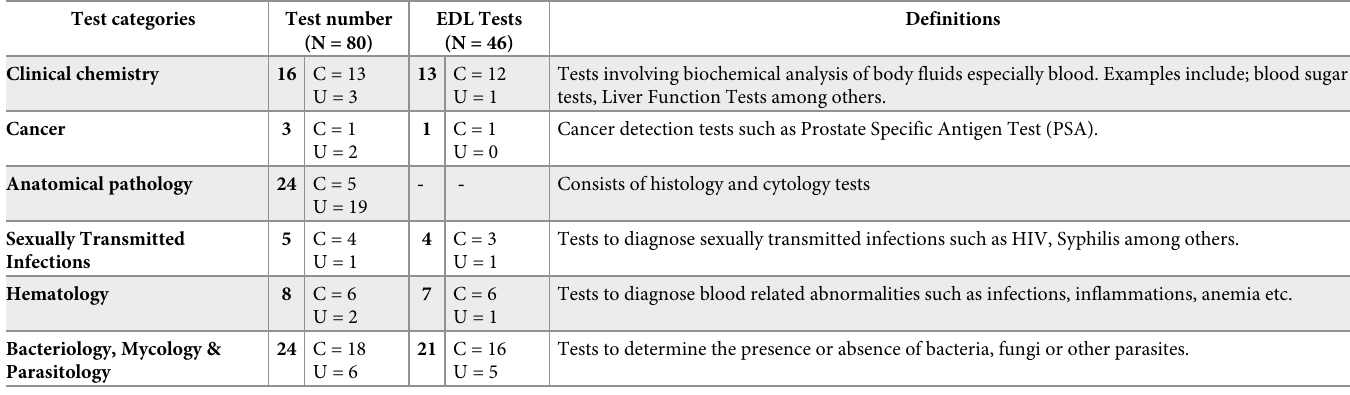
Table 1. Test categories of the 80 laboratory tests